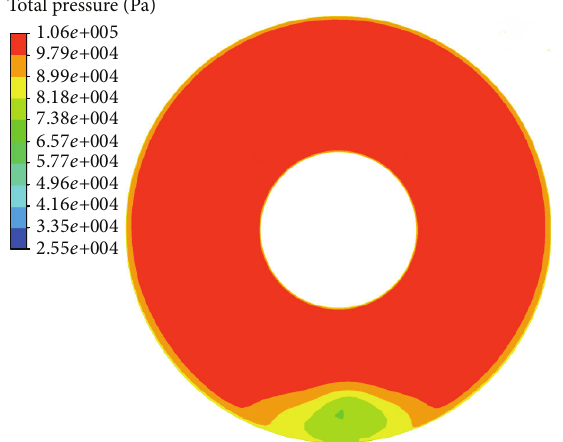
Figure 17: Contours of the total pressure on the fan face obtained by a steady state